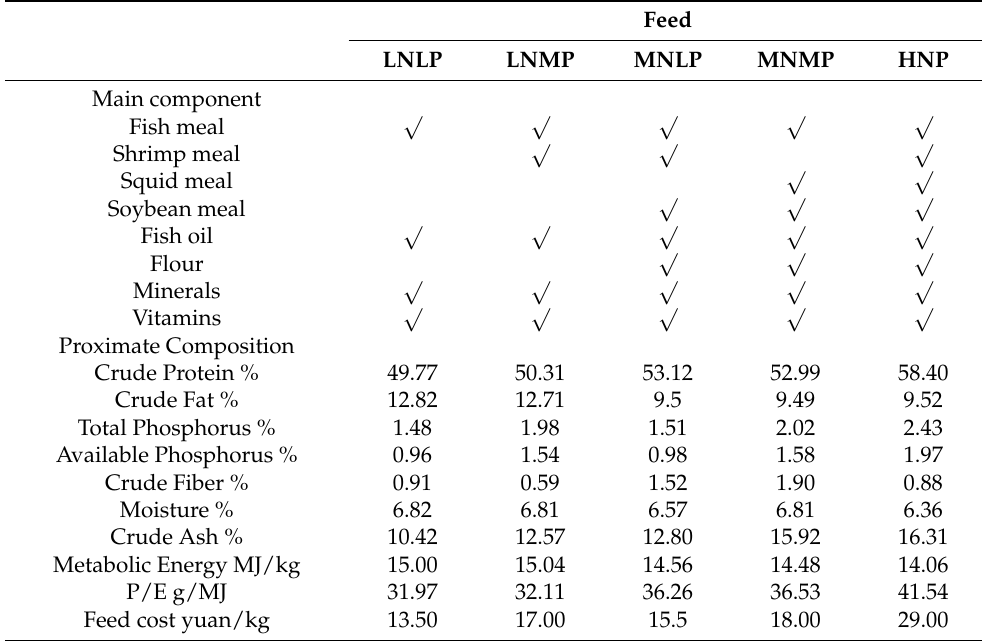
Table 1. Composition of the experimental feeds.